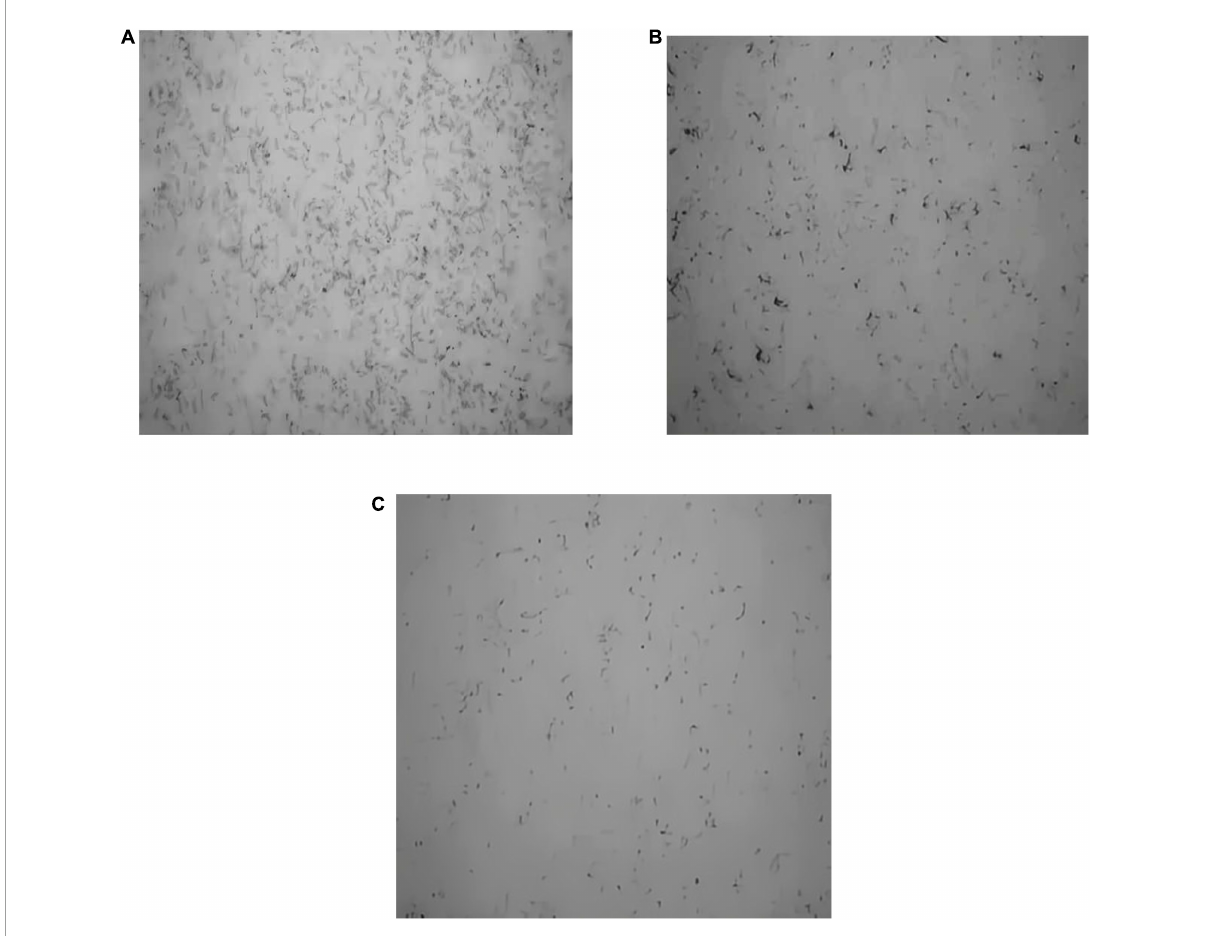
FIGURE8 Effect of anthocyanin on the biofilm formation of Staphylococcus aureus by silver staining method. (A) Is the control group; (B) is the anthocyanin (MIC)-treated group; (C) is the anthocyanin (2 MIC)-treated group.